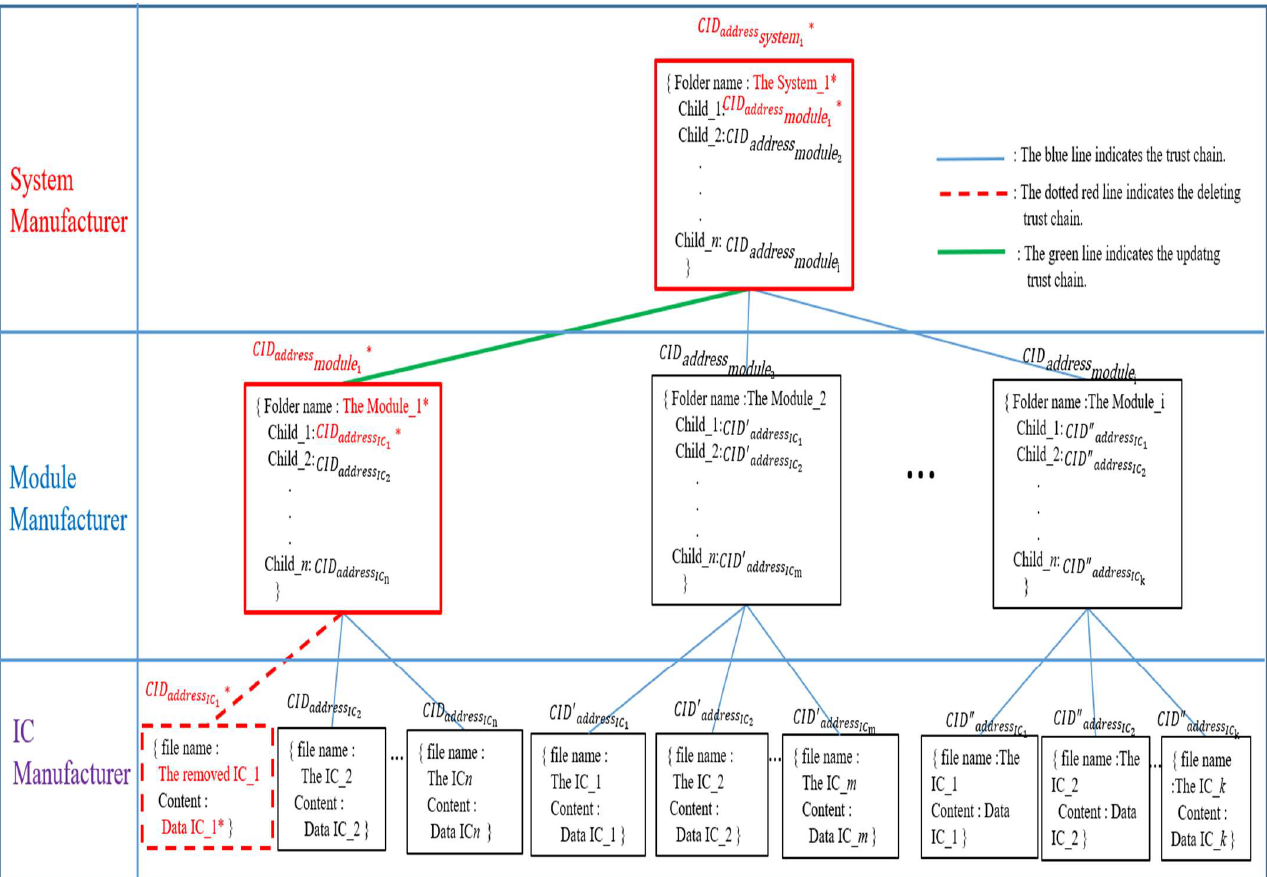
Figure 13. Merkle DAG in HCIDM performed in web-based DApp is activated and re-organized the trust chain in our framework on when IC_1 data is deleted, where the symbol “*” is used to indicate the version of CID address (or said hash value) has been undated.